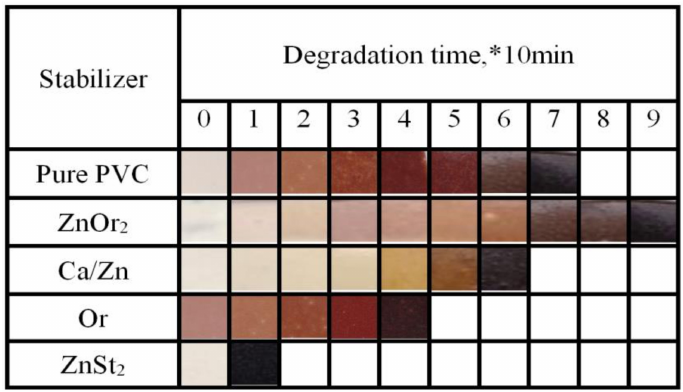
Figure 4. The effects of discoloration for PVC with different kinds of thermal stabilizers at 180 ◦